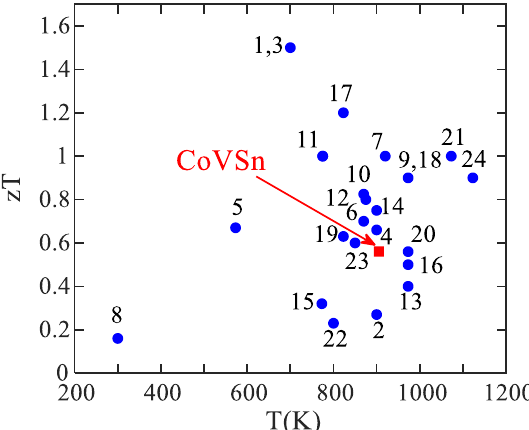
Figure 1. Selected alloys with their corresponding TE properties, which have been studied as half-Heusler (numbers are the items given in Table 1). Table 1. Compounds cited in Figure 1.